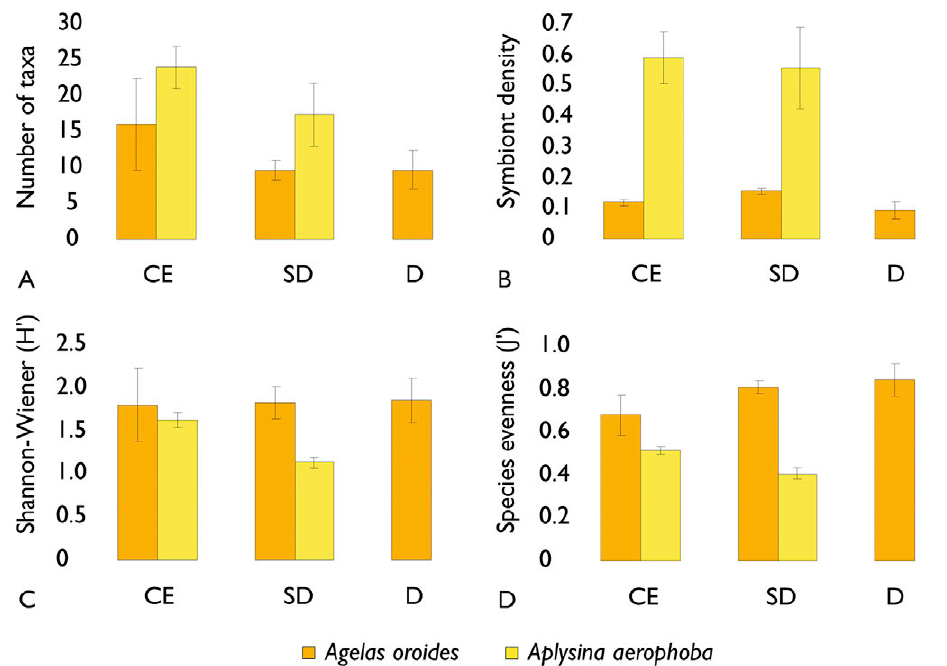
Fig. 5. – Mean number of taxa (A), density (B), Shannon-Wiener diversity (C) and species evenness (D) of symbionts for the sponges Agelas oroides and Aplysina aerophoba across the surveyed caves (CE, entrance; SD, semidark zone; D, dark zone). Standard error of mean is presented in error bars.